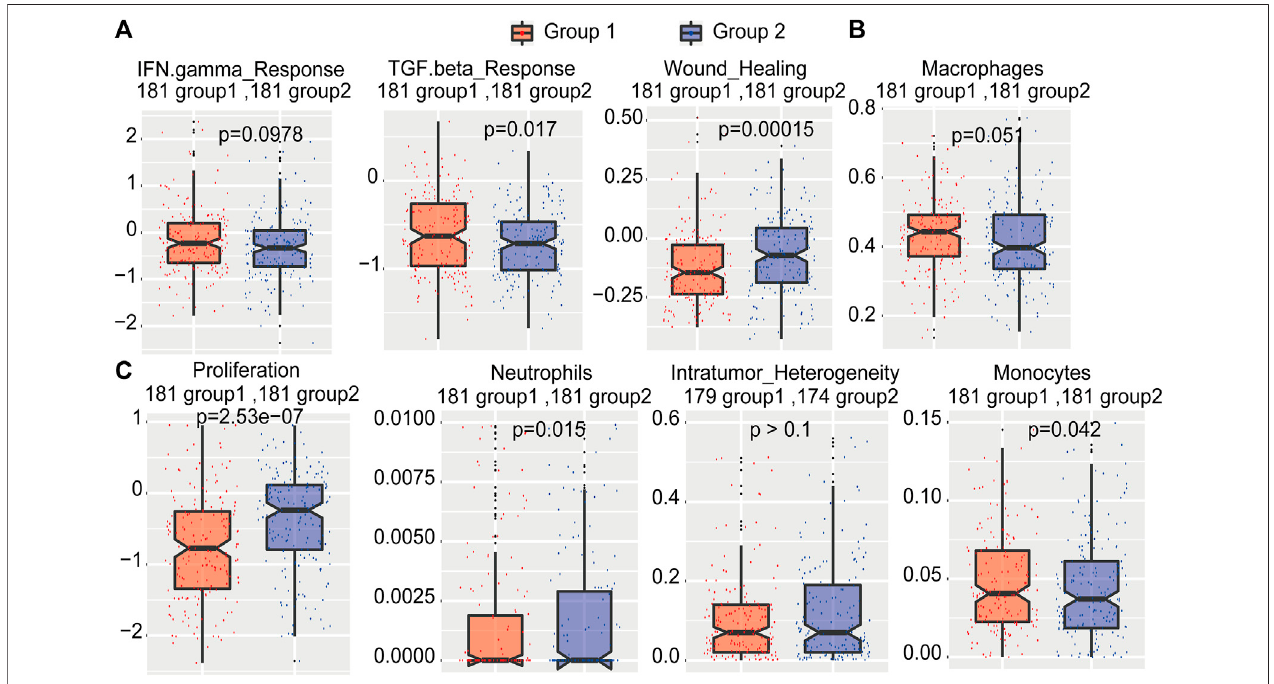
FIGURE 8 | The distribution of immune characteristics of HCC